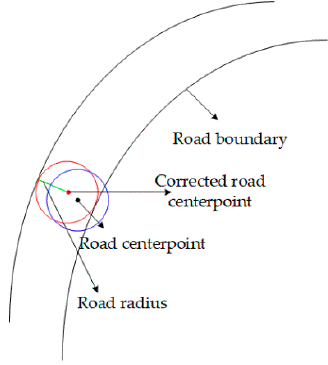
Figure 10. Centerpoint autocorrection.